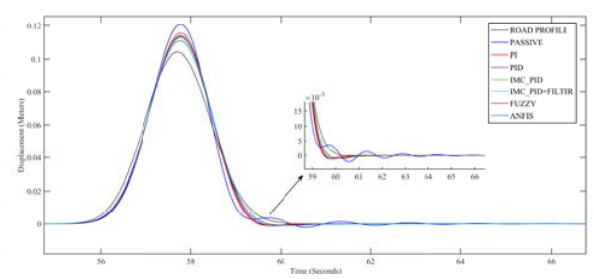
Figure 16. Response against Road profile